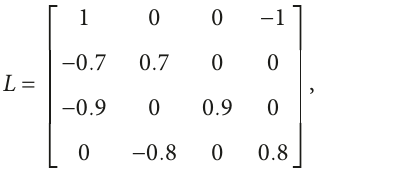
Figure 10: The trajectories of x under asymmetric time delays when all τ m > τ up